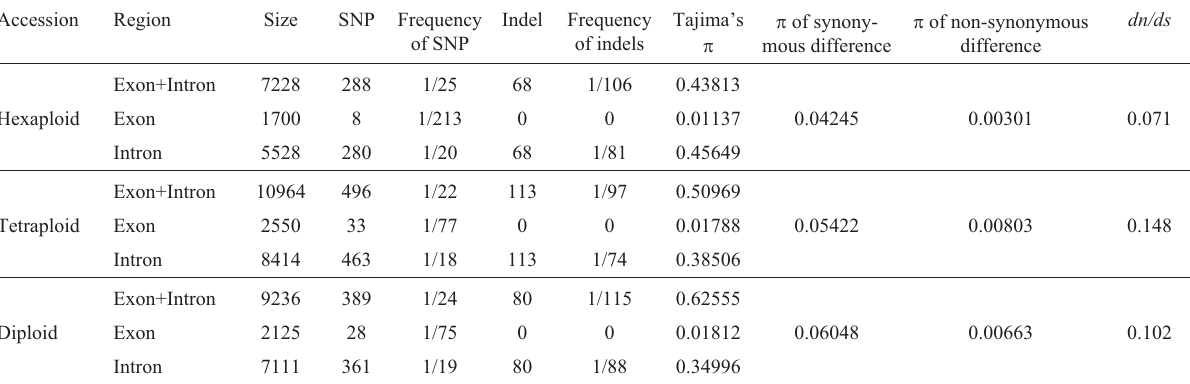
Table 3 - SNPs and indels of the WAG-2 partial sequences identified in all accessions and comparison of genetic diversity. Accession Region Size SNP Frequency